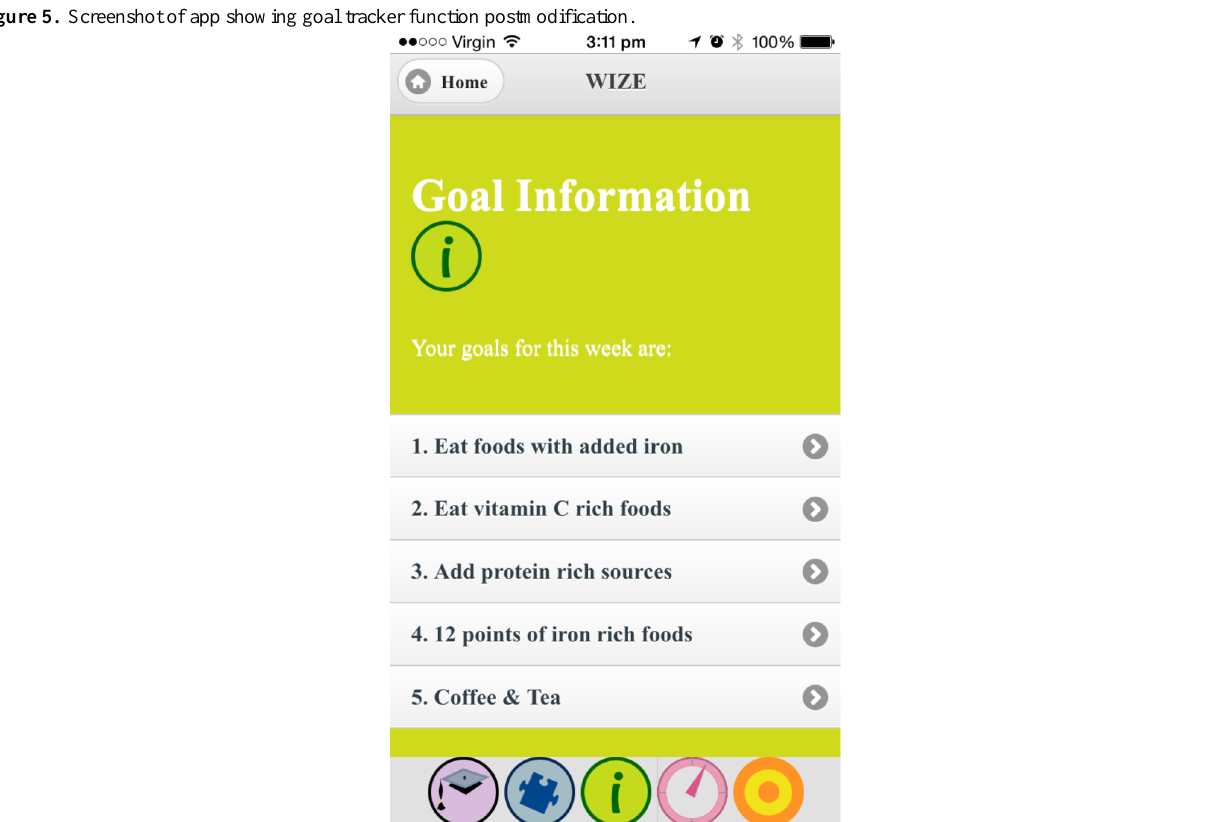
Figure 5. Screenshot of app showing goal tracker function